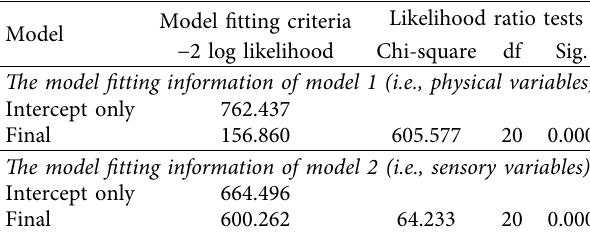
Table 7: The model fitting